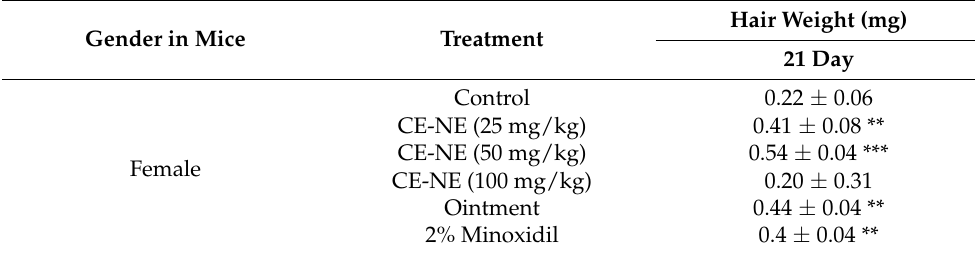
Table 5. Effect of cedrol on hair weight.